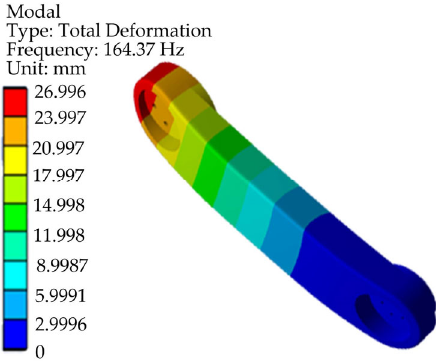
Figure 13. Total deformation of the big arm under the first-order modality.